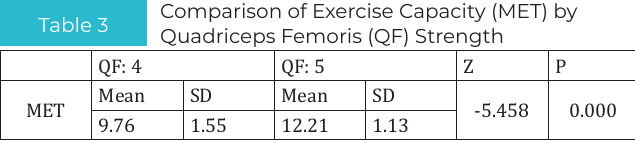
Figure 1a - Box Plot of Exercise Capacity by Quadriceps Femoris Muscle Strength